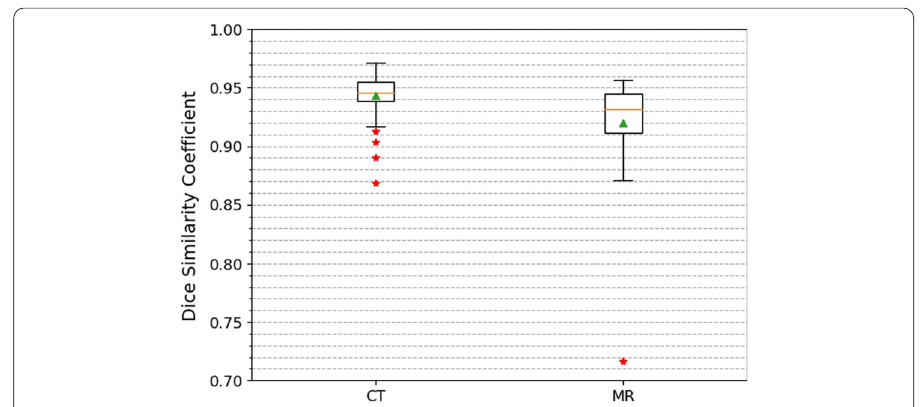
Fig. 5 DSCs between manual liver segmentations and CNN liver segmentations of 49 CT and 26 MR images from the 20 SIRT patients selected for the registration experiment. The orange line, green triangle, and red stars represent median, mean, and outliers, respectively. The box corresponds to the first and third quartiles, and the whiskers give the range (except for the outliers)